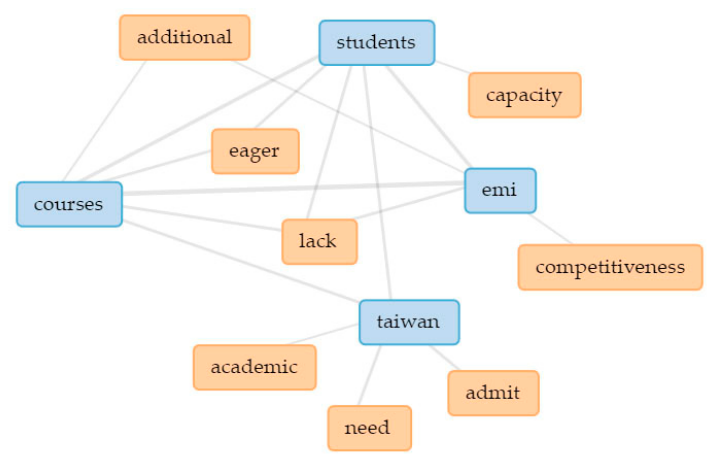
Figure 5. Interrelationships and extended links among the perceived EMI strengths.